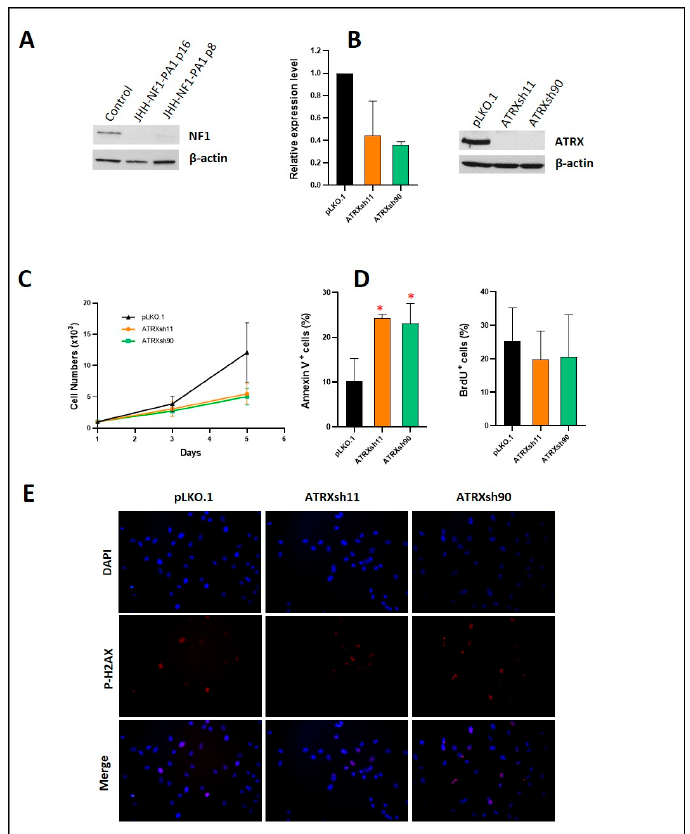
Figure 2. ATRX knockdown in the human glioma cell line JHH-NF1-PA1. NF1 pediatric pilocytic astrocytoma cell line JHH-NF1-PA1 has pronounced NF1 loss in culture ( A ). Successful ATRX knockdown (mRNA left, protein right) using shRNA hairpins ( B ). ATRX loss leads to decreased growth of JHH-NF1-PA1 ( C ), primarily through increased apoptosis ( D ). Short-term ATRX loss increased p-H2AX foci ( E ). (* p < 0.05).